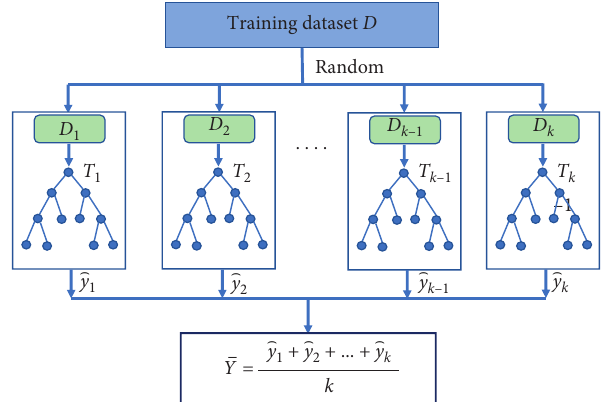
Figure 3: The architecture of the random forest